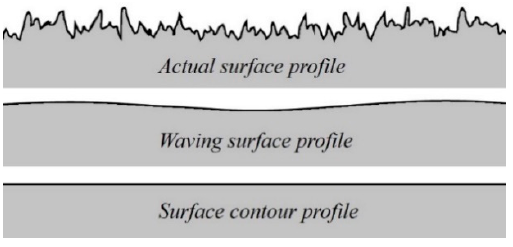
Figure 1. Three types of surface topography.